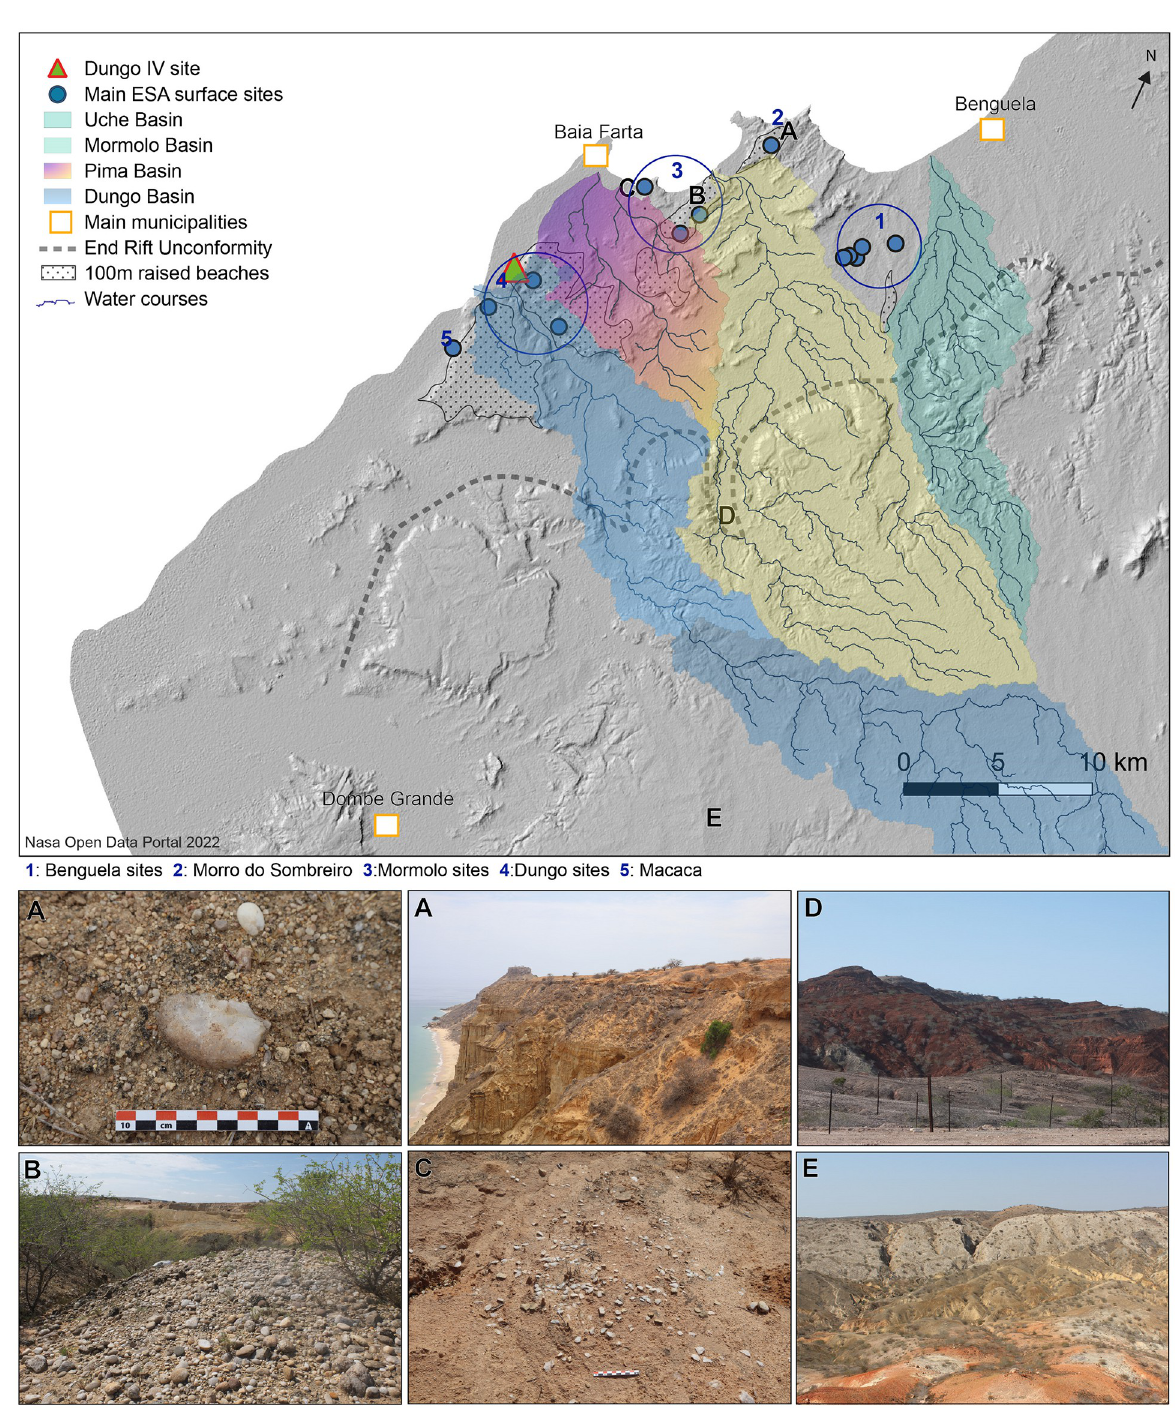
Fig 2. Locality of the ESA surface sites and Dungo IV on the +100 m raised beaches between Benguela and Dombe Grande, based on Museu Nacional de Arqueologia de Benguela records, surveys and test-pits (157 , 158) , and hydrographical settings of the areas. The photo letters refer to the letters on the map and show Morro do Sombreiro Red Sand deposits on the +100 m raised beach (A), the cobble/pebble outcrops of the +100 m raised beaches at Mormolo (B), a quartz lithic workshop on a deflated surface within the base of the Red Sand deposit of the +100 m raised beach at Ponta das Vacas (C) and the End Rift Unconformity landscapes (D and E)–Hydrographical settings have been mapped by J. Matos and photos are from I. Mesfin. Reprinted from Nasa Open Portal under a CC BY license, with permission from Nasa Open Portal, original copyright